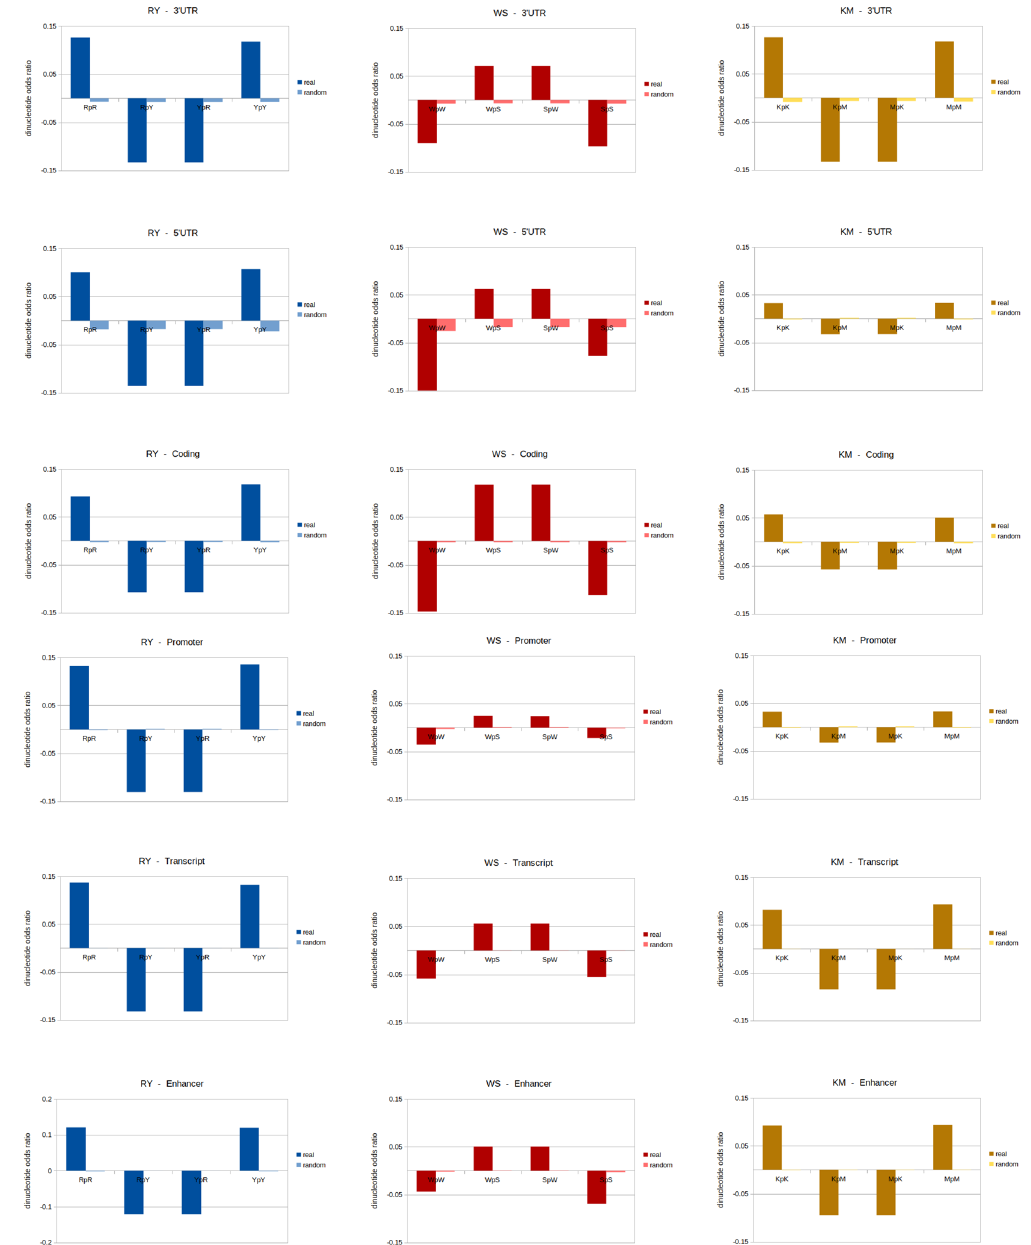
Figure 5. General design profiles for the RY, WS, and KM binary components, according to genomic location. These charts show the general designs profile for each binary component RY, WS, and KM separately, in each of genomic sequence locations. These locations include the 3 ′ UTR, 5 ′ UTR, coding, promoter, transcript, and enhancer. For each binary components, the dinucleotides odds ratios are calculated for all possible four dinucleotides, and results here are the mean values within the given genomic sequence type. Equivalent values for random-shuffled sequences are shown. A value of zero is equivalent to the random model.